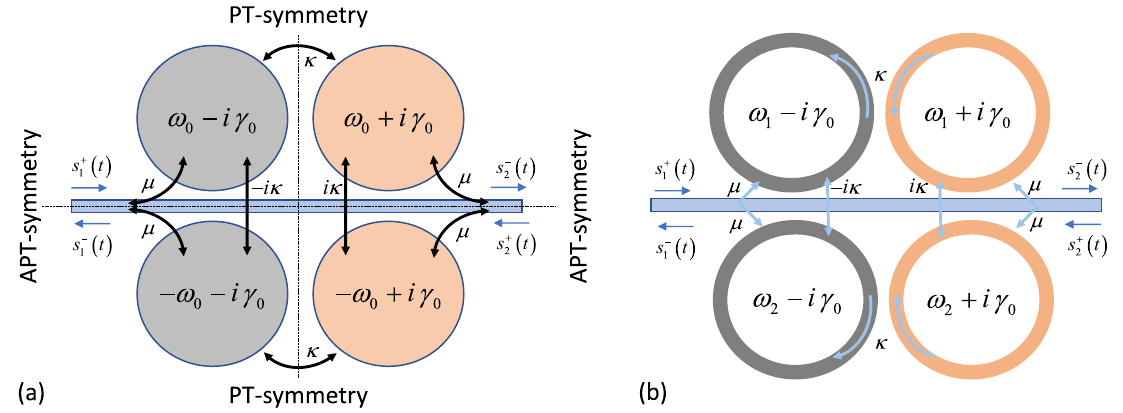
Figure 1: (a) Conceptual schematic of a hybrid PT-APT-symmetric system. The system is PT-symmetric with respect to the vertical axis and APT-symmetricwithrespecttothehorizontalaxis.Couplingbetweentheresonatorandthewaveguideis μ andcouplingbetweenresonatorsis κ ontheverticalaxisand ± i κ onthehorizontalaxis,where κ is purelyrealand μ is a complexparameterfunctionof thescatteringmatrixof the direct process. ± ω 0 are the resonant frequencies and ± γ 0 are the gain/loss parameter. (b) A nanophotonic implementation based on four active/passive ring resonators and a bus